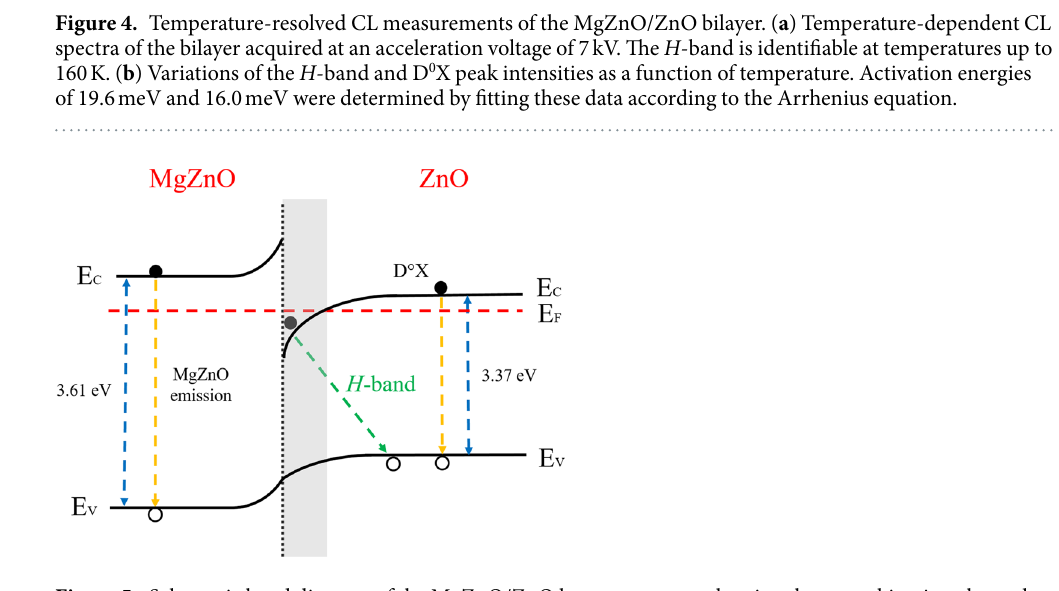
where P sp ( x ) is the spontaneous polarization in the Mg x Zn 1 − x O layer and P pe is the piezoelectric polarization, respectively. Analytical solutions for each of the polarization terms have previously been determined by solving = − 0.0322 + 0.024 x C/m 2 and P x ( ) = − 0.0584 x . For the Poisson and Schrödinger equations 37 , which yield P x ( ) sp pe MgZnO/ZnO heterostructure in this work ( x = 0.164), σ = . C m 0 0135 / 2 , which is consistent with the value obtained from the interface scattering model for MgZnO/ZnO heterostructures 38 .